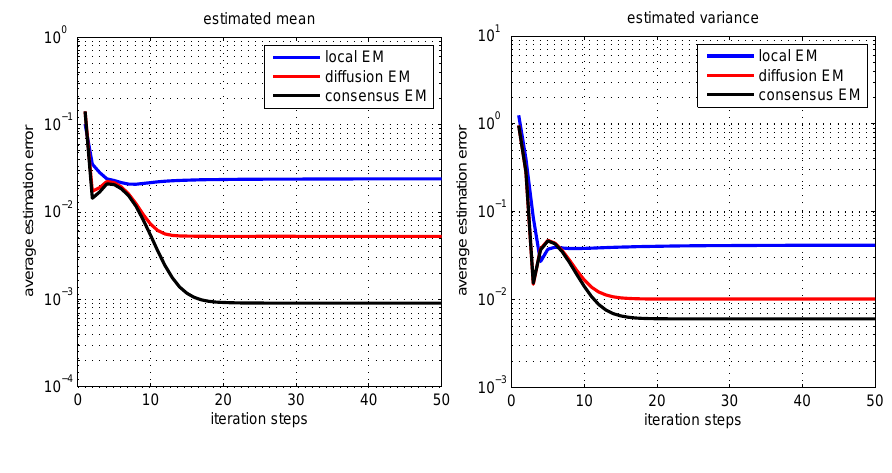
Figure 3. Performance comparison for different EM algorithms.